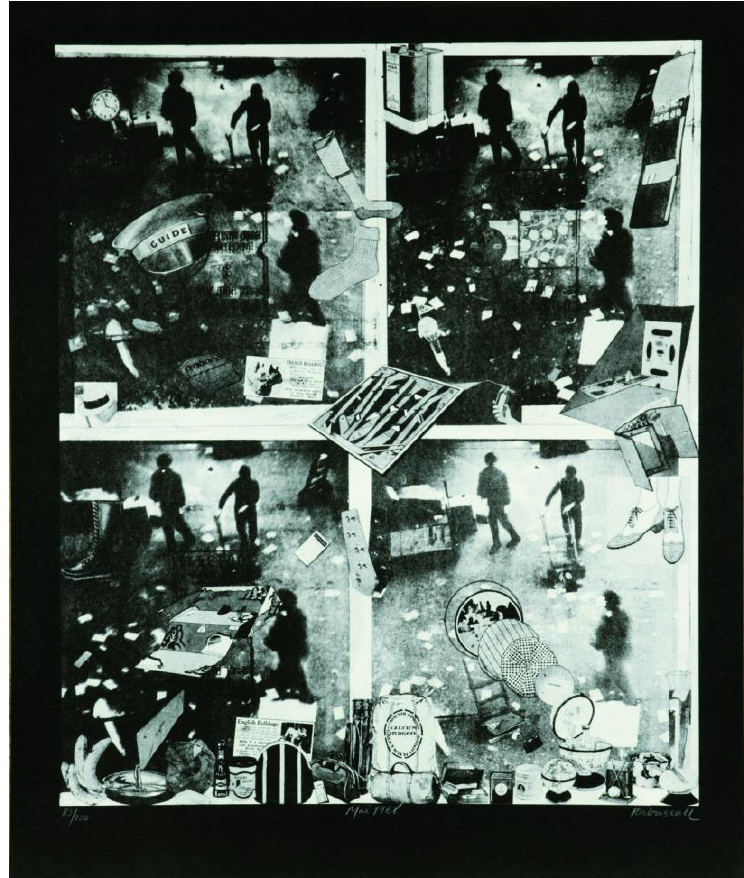
Figure 3. Joan Rabascall, MAI 68 , 1968, Graphic material, Offset lithography on paper, 56 × 47 cm, Museu d'Art Contemporani de BarcelonaCollection. Museu d'Art Contemporani de Barcelona